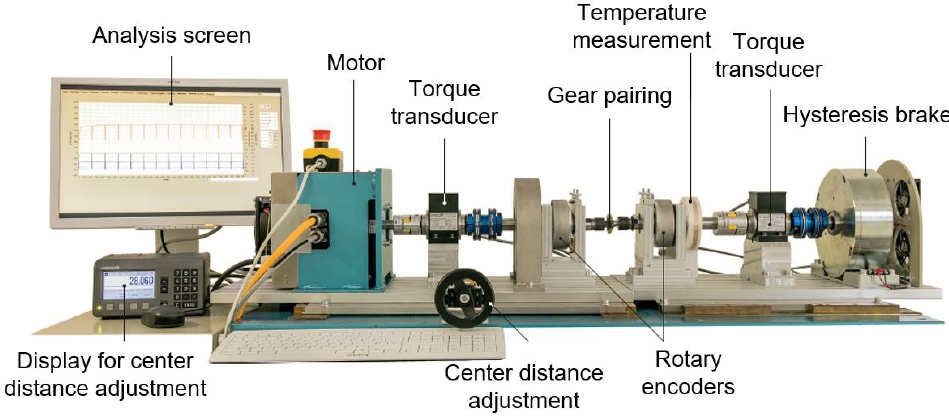
Figure 2. Main components of the in situ gear test rig of the LKT [6].